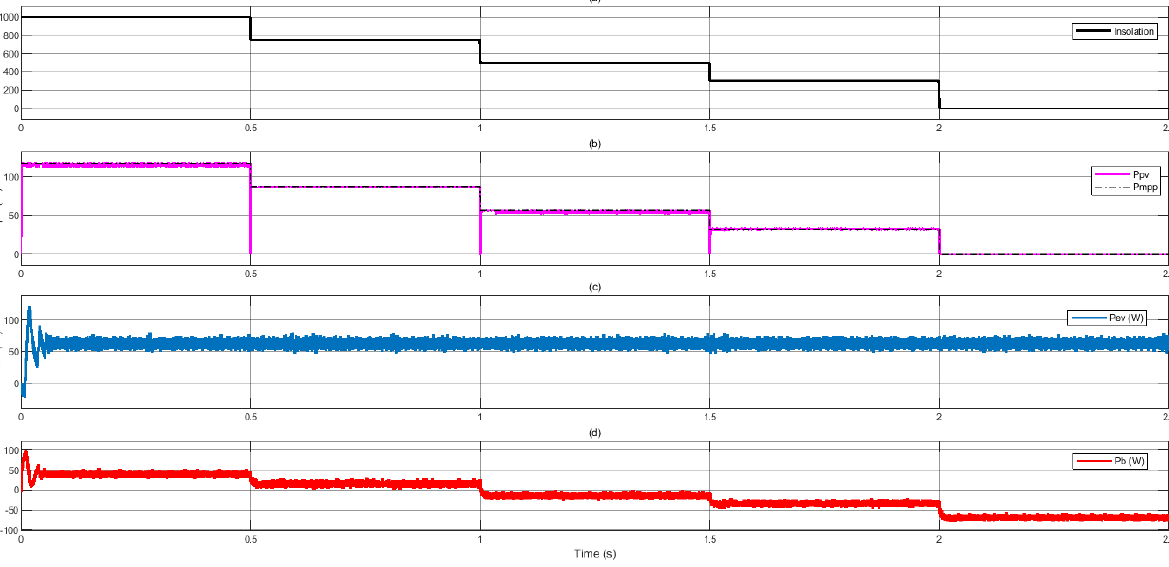
Figure 8. The system response with the PI controller: ( a ) the sun insolation level, ( b ) the DC bus voltage, ( c ) the ESS battery current, and ( d ) the EV battery current. Figure 9 shows the response of the PV power, the ESS battery power, and the EV battery power against the solar insolation level for the PI controller. All the variables track the references very well. However, the performances are less than that of the fuzzy controller shown in Figure 7.